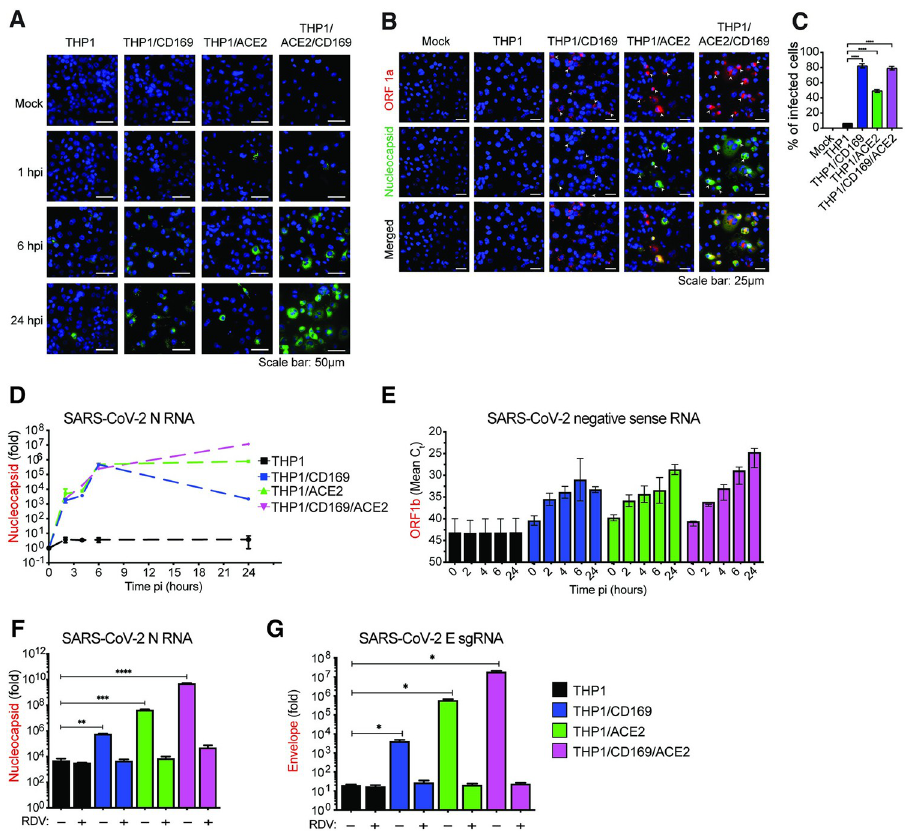
Fig 4. CD169-mediated SARS-CoV-2 infection results in restricted viral RNA expression in THP1/PMA macrophages. ( A ) Single molecule RNA FISH analysis of viral positive sense gRNA using high fidelity probes in SARS-CoV-2 infected THP1/PMA macrophages (MOI = 10) at the indicated timepoints. Representative fields of cells were hybridized at indicated times with 7 sets of smFISH probes labeled with Quasar670 targeting the + strand of SARS-CoV-2 ORF1a (NSP1-3) and N transcripts. Data are representative of 2 independent experiments. Bar = 50 μ m. ( B ) smFISH analysis of viral RNAs using ORF1a specific probe set (labeled with Texas Red) and N specific probe set (labelled with TMR) in SARS-CoV-2 infected THP1/PMA cells (MOI = 10, 24 hpi). Data are representative of 2 independent experiments. Bar = 25 μ m. ( C ) Percentage of infected cells based on the presence of SARS-CoV-2 RNAs determined from 10–20 independent fields (representative field shown in B ). ( D - G )THP1/PMA macrophages infected with SARS-CoV-2 (MOI = 1) in the absence ( D - E ) or presence ( F - G ) of remdesivir (RDV, 1 μ M). Total RNA was harvested at indicated times post-infection and expression of viral transcripts was quantified by RT-qPCR. Replication kinetics of SARS-CoV-2 were quantified by ( D ) total N RNA amplification (values from each group normalized to mock (uninfected) or ( E ) negative sense antigenome from strand-specific reverse-transcription and ORF1b amplification (mean Ct values for each condition). Expression of total N RNA ( F ) and E sgRNA ( G ) transcripts in THP1/PMA macrophages was analyzed at 24 hpi. Values from each group normalized to mock (uninfected). The means ± SEM are shown from at least 3 independent experiments. Significant differences between groups were determined by one-way ANOVA followed by the Dunnett’s post-test ( C, F - G ), comparing to parental THP1 cells. P - values: � < 0.1; �� < 0.01; ��� < 0.001; ���� <